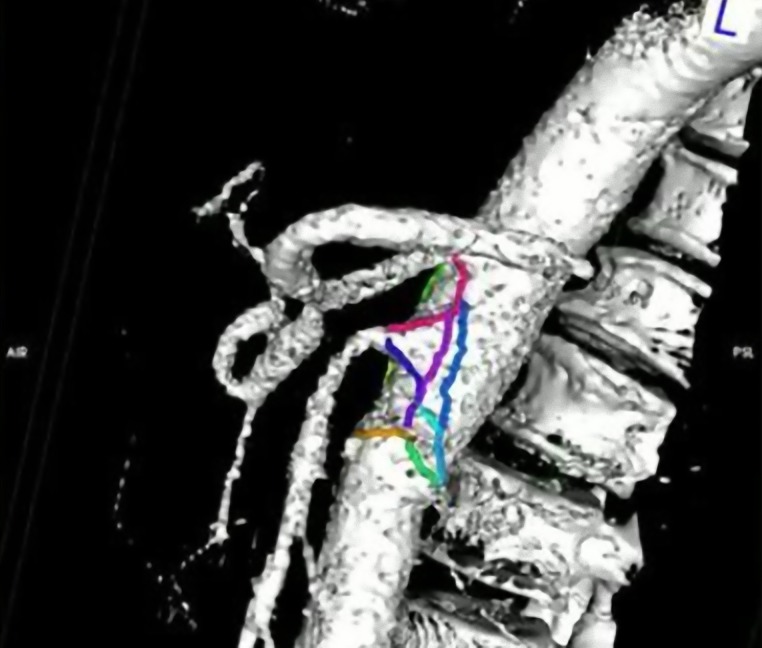
Three-dimensional view of paths along surfaces on a surface model produced using the Surface Length 3D plugin and OsiriX.